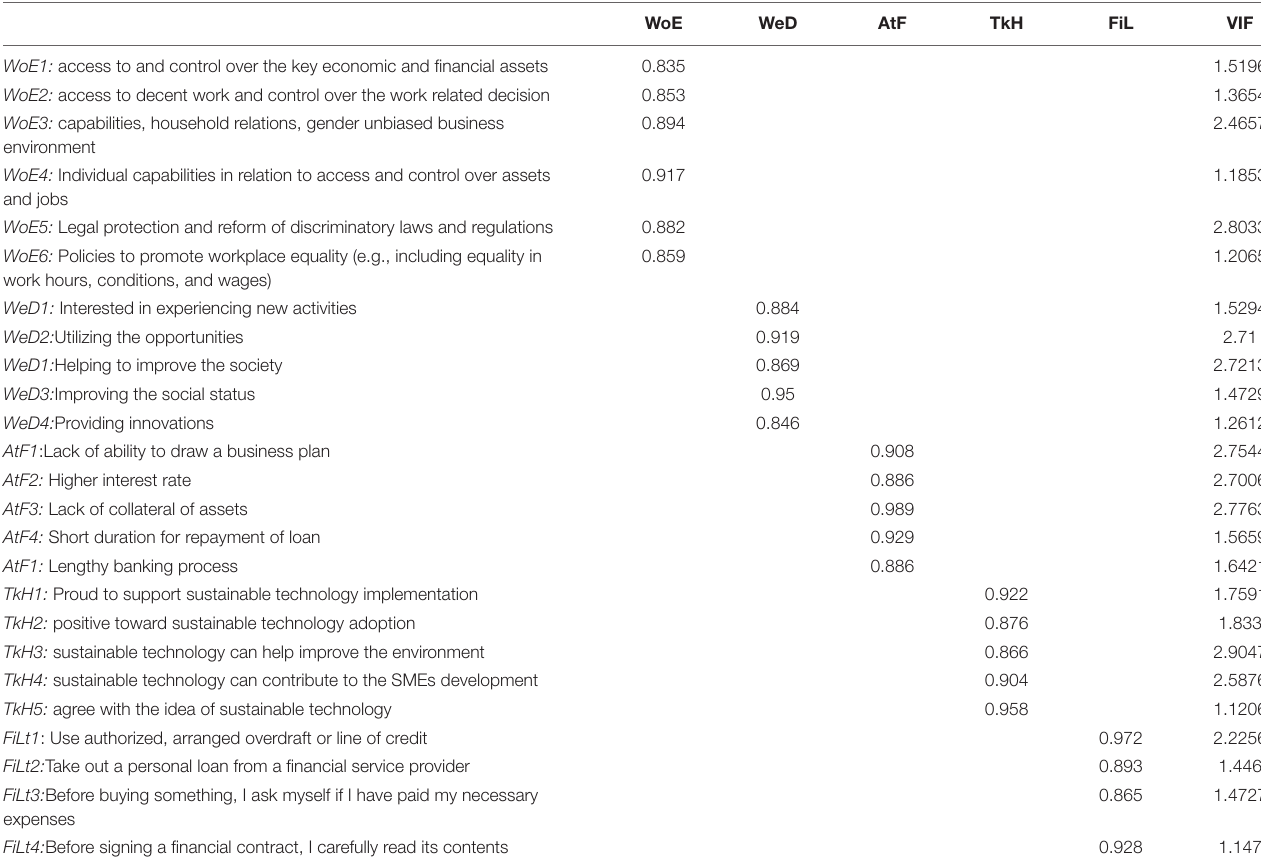
TABLE 4 | Outer loading and